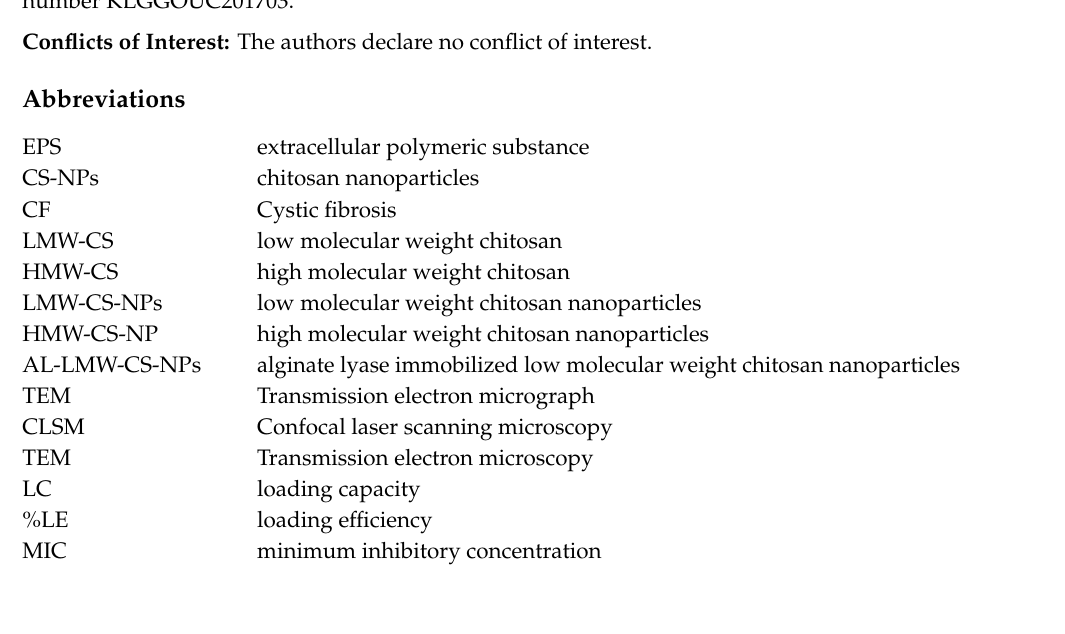
s1. Figure S1: Transmission electron micrograph (TEM) analysis of high molecular weight chitosan